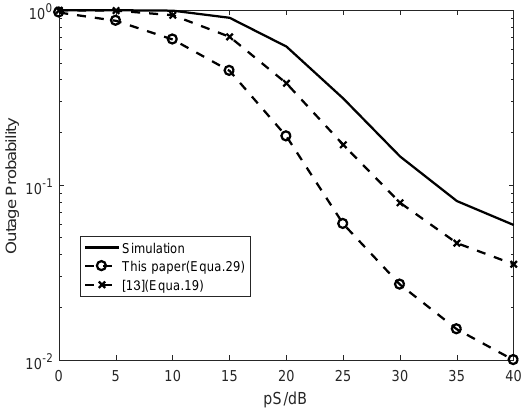
Figure 6. Outage probability of HHWN with MMR of different emission